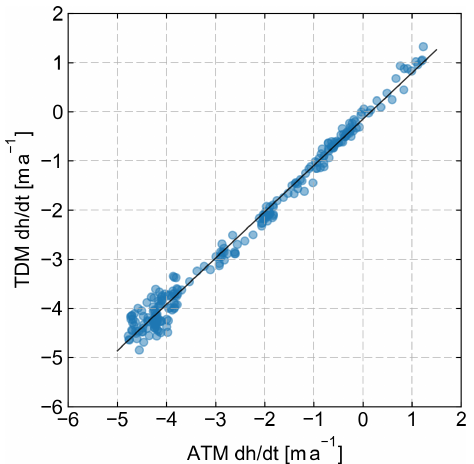
Figure 1. Scatter plot of measurements of surface elevation change (d h/ d t ) 2016–2011 on the central flow line of Crane Glacier based on IceBrigde ATM and TanDEM-X elevation data. The line shows the linear